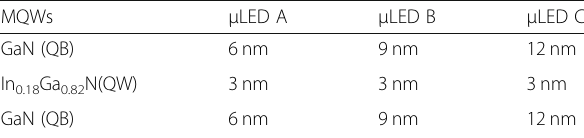
Table 1 The structural parameters of the active region for μ LEDs A, B, and